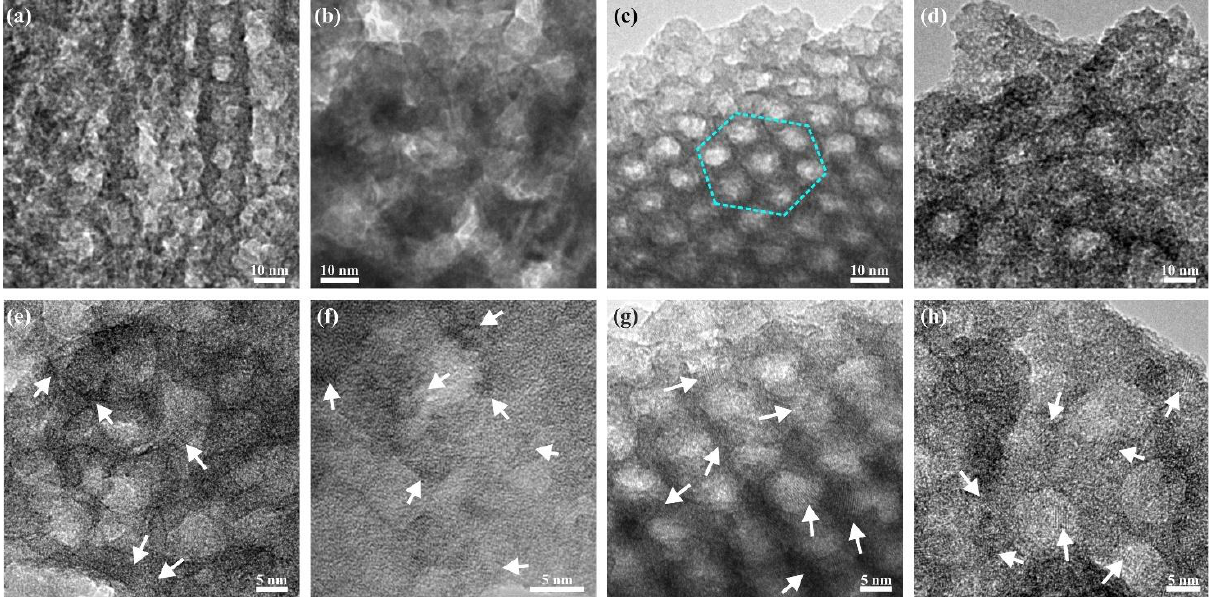
Figure 4. (HR)TEM images of mesoporous titania with 3 h synthesis time, deposited with 60 s spray coating and aged at 75% RH for ( a , e ) 1 h, (b,f) 48 h, ( c , g ) 72 h, and ( d , h ) 120 h. A hexagonal pore order was achieved for the sample aged for 72 h and is outlined with dotted cyan line ( c ). White arrows indicate some of the anatase crystallites.